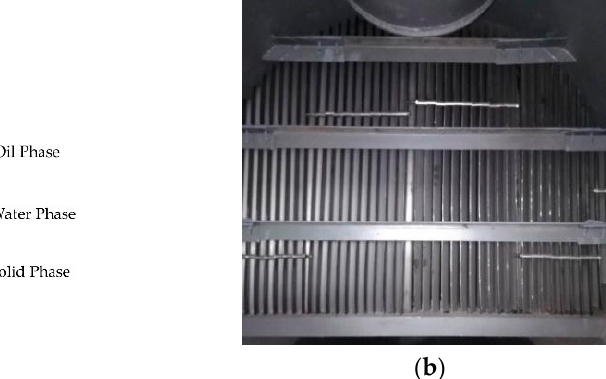
Figure 4. Schematic diagram of the installation position of each component inside the separator.